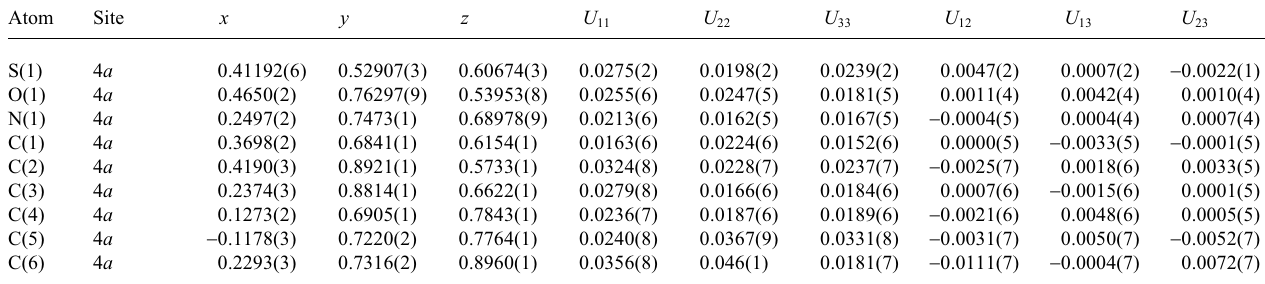
Table 3. Atomic coordinates and displacement parameters (in Å 2 )